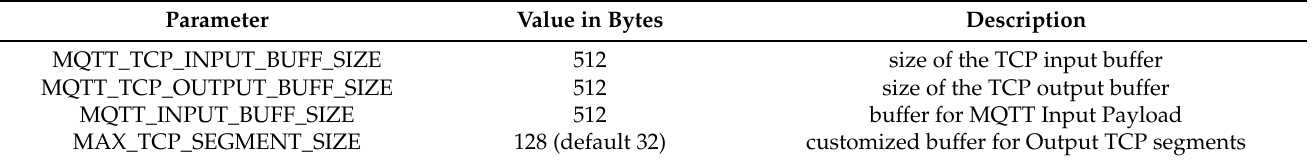
Table 5. Parameter settings in Contiki-NG.